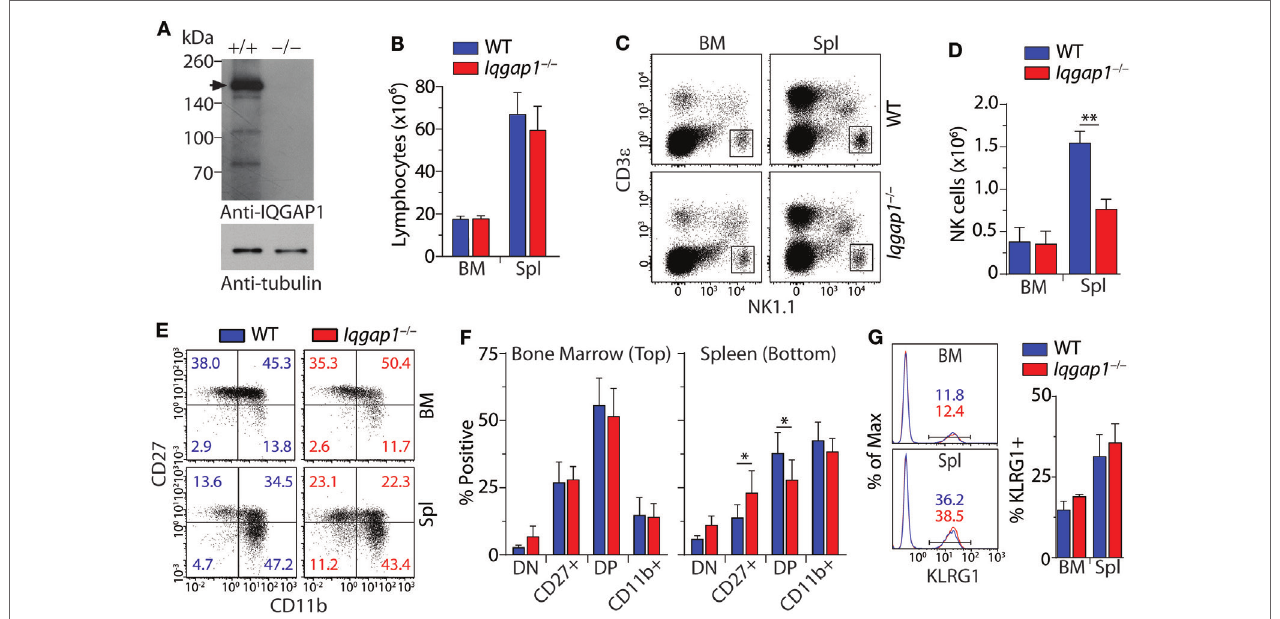
FigUre 1 | Characterization of natural killer (NK) cell development and maturation in Iqgap1 − / − mice. (a) Evaluation of IQ domain-containing GTPase-activating protein 1 (IQGAP1) in wild-type (WT) and Iqgap1 − / − NK cells by western blot. The black arrow indicates full-length IQGAP1 at approximately 190 kDa. Whole cell lysates were prepared from IL-2-cultured NK cells and α -tubulin serves as the loading control. (B) Flow cytometry was used to calculate lymphocyte numbers in the bone marrow (BM) and spleen based on FSC and SSC parameters. (c) Representative dot plots showing NK cell gate (CD3 ε − NK1.1 + ) used to calculate total NK cell numbers in the BM and spleen as shown in panel (D) . (e) Representative dot plots of CD27 and CD11b expression on NK cells (CD3 ε − NK1.1 + ) and (F) quantification of the DN (CD27 − CD11b − ), CD27 + (CD27 + CD11b − ), DP (CD27 + CD11b + ), and CD11b + (CD27 − CD11b + ) populations were quantified in the BM and spleen. (g) Representative histograms are showing the percentage of KLRG1 + NK cells (CD3 ε − NK1.1 + ) and quantification of these populations in the BM and spleen. Error bars represent SD using four to six mice in at least two independent experiments, * p < 0.05 and ** p < 0.01 using two-tailed Student’s t